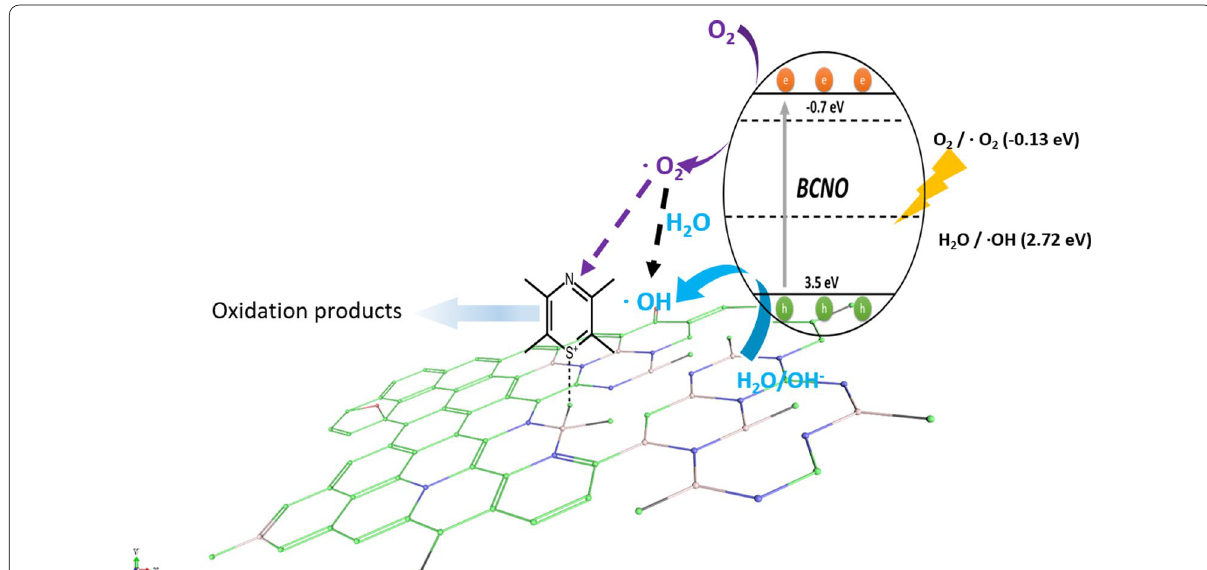
Fig. 8 Schematic illustration of the proposed mechanism of BCNO in catalyzing the degradation of MB upon light irradiation. The positively charged MB was selectively absorbed on the N 2 B‑OH sites. The band structures of BMH03 were determined via UPS and Tauc plot (Fig. 6 and Additional file 1: Fig. S17). The redox potentials of O 2 /O 2